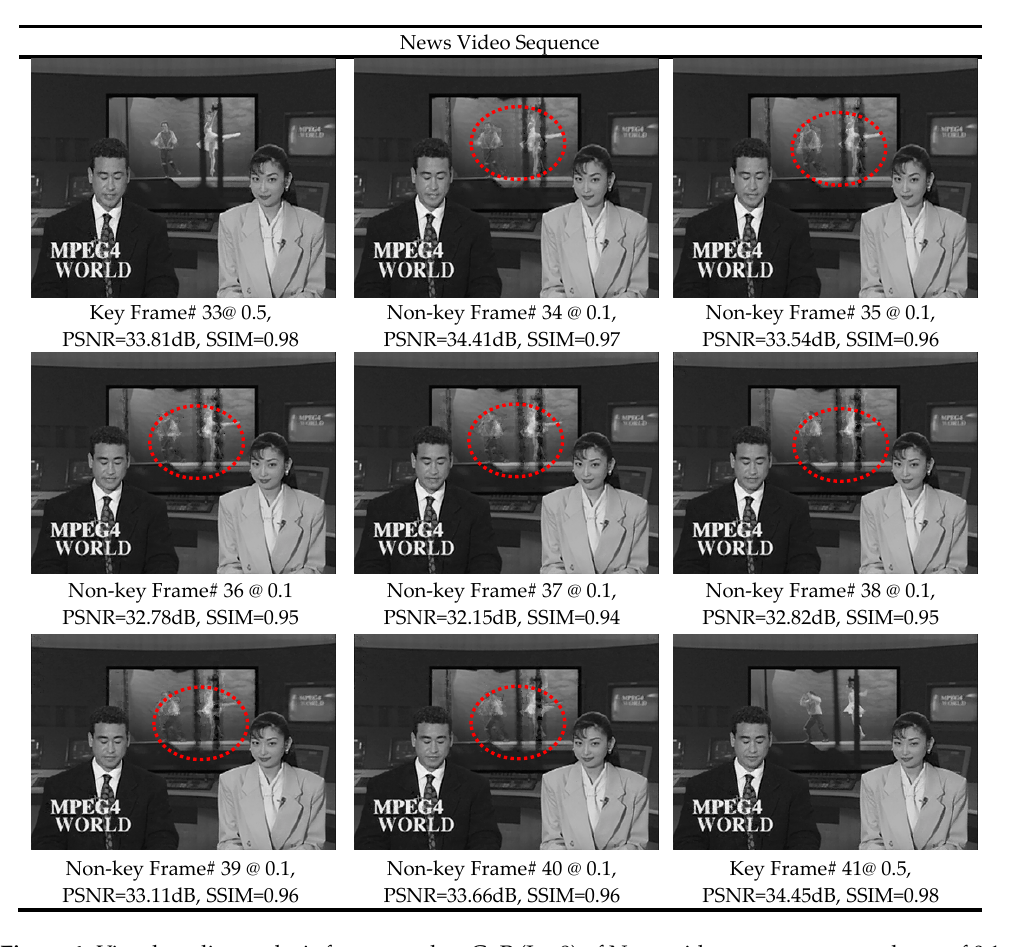
Figure 4. Visual quality analysis for a complete GoP (J = 8) of News video sequence at a subrate of 0.1 using proposed JD-TV framework.